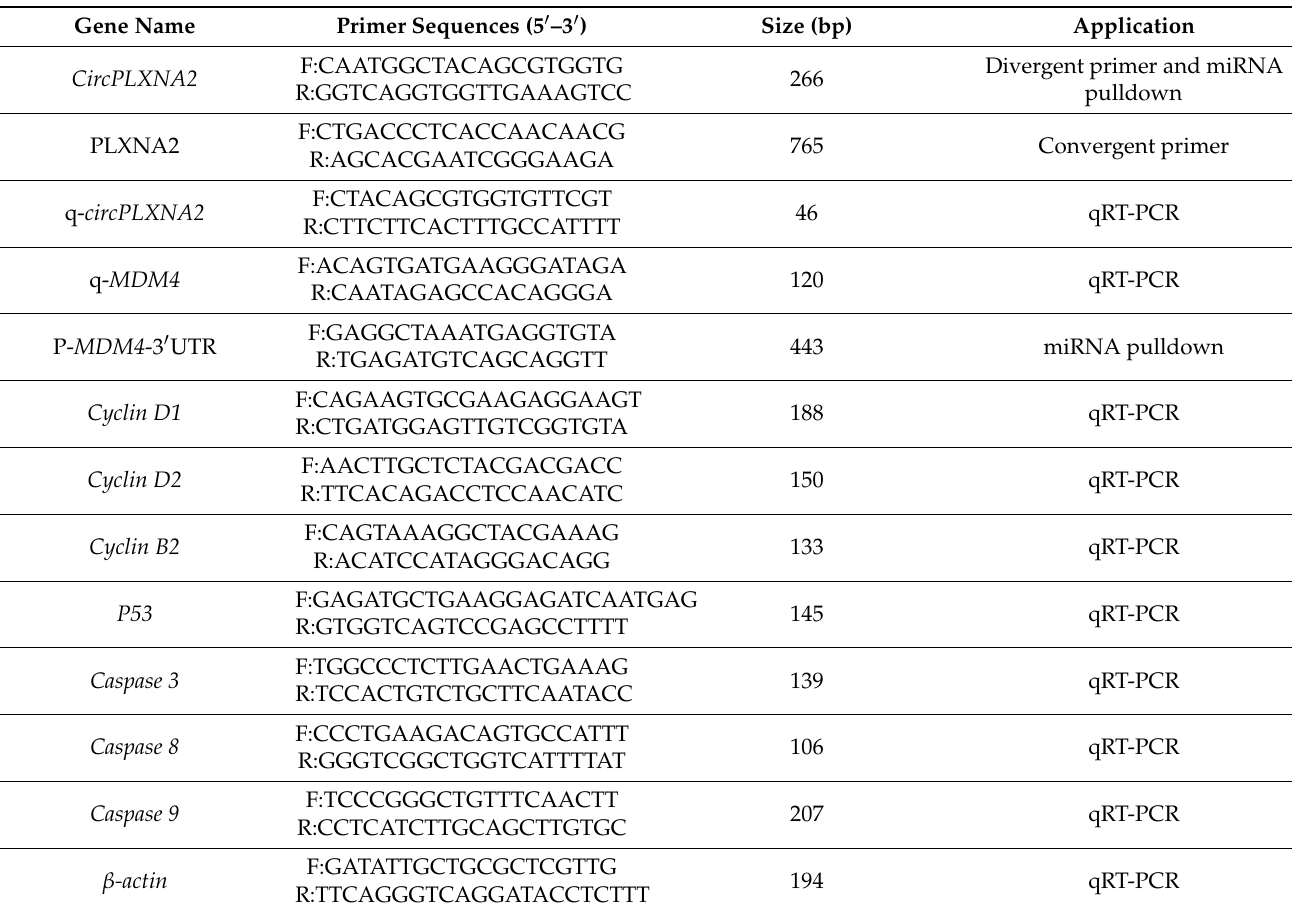
Table 1. Primers used in this study.